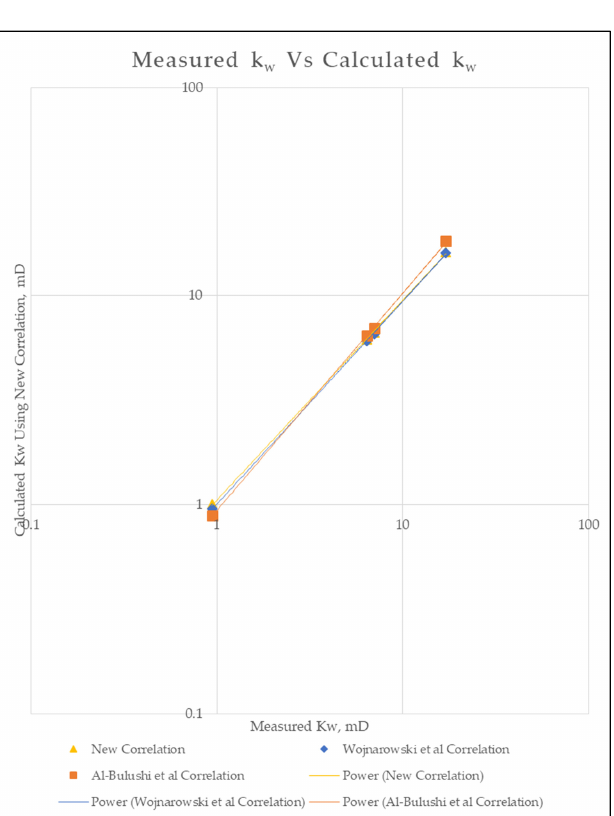
Figure 15. Graph of comparison between measured k w vs. calculated k w of PETRONS-2 core samples using different correlations.